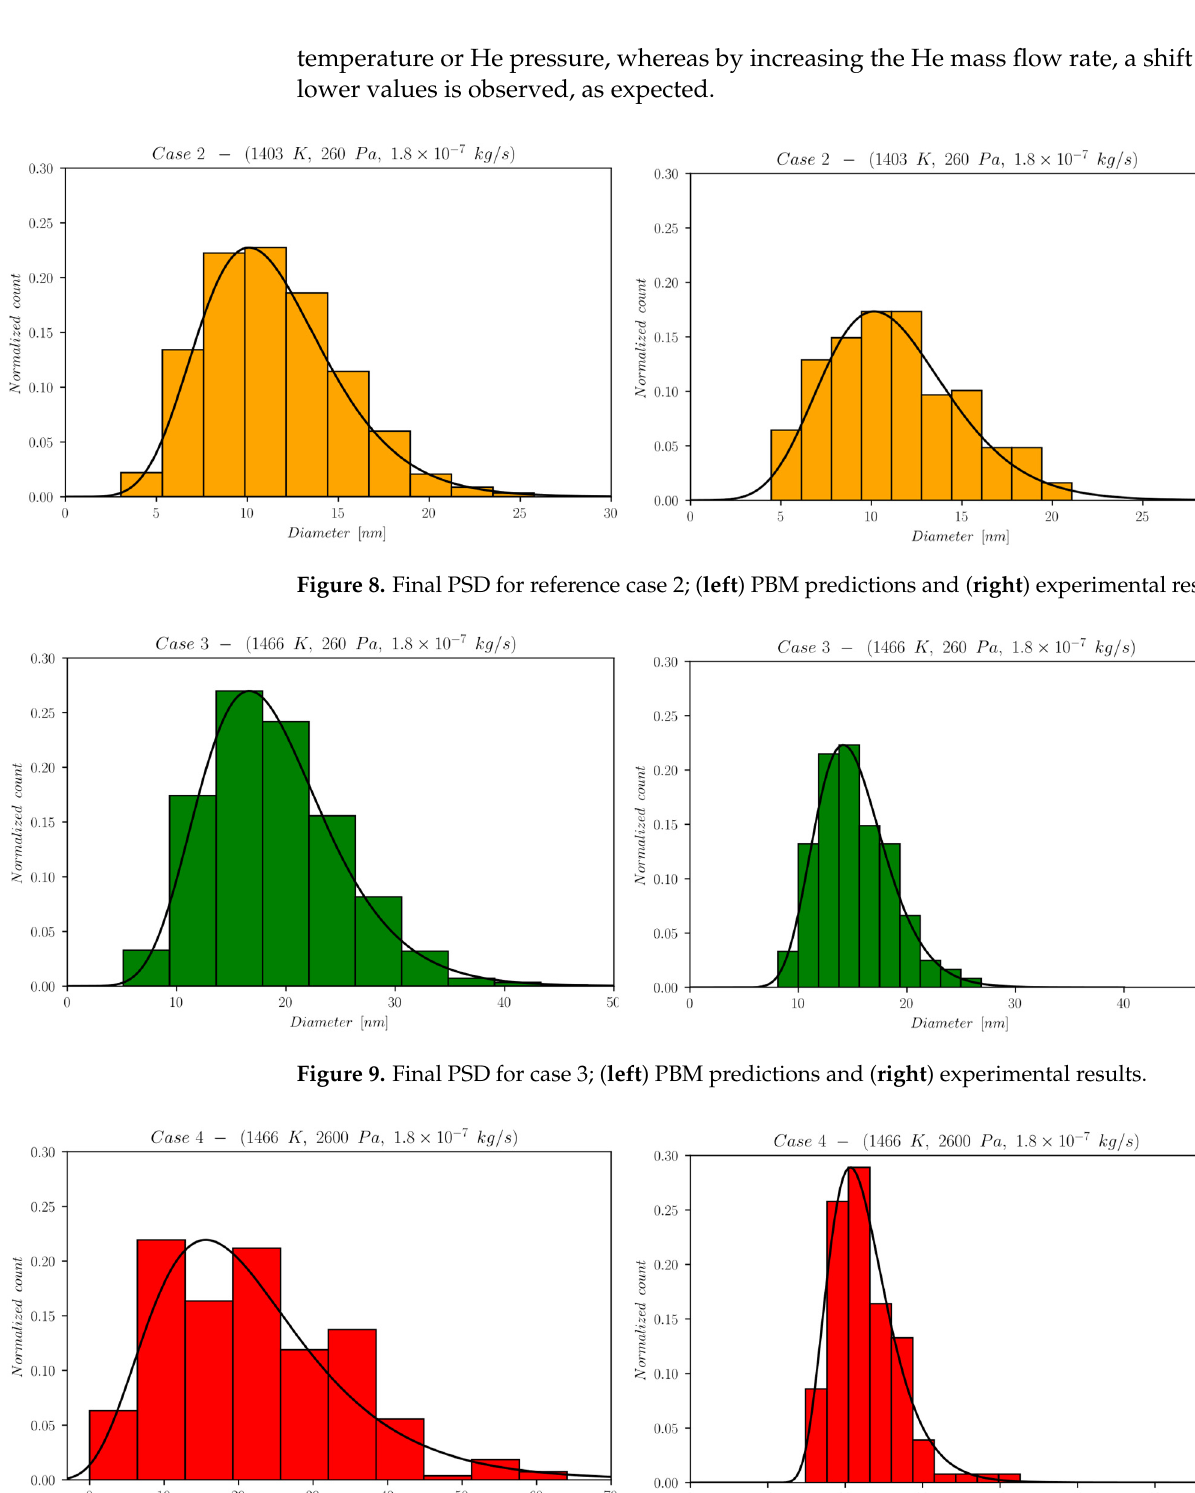
Figure 10. Final PSD for case 4; ( left ) PBM predictions and ( right ) experimental results.